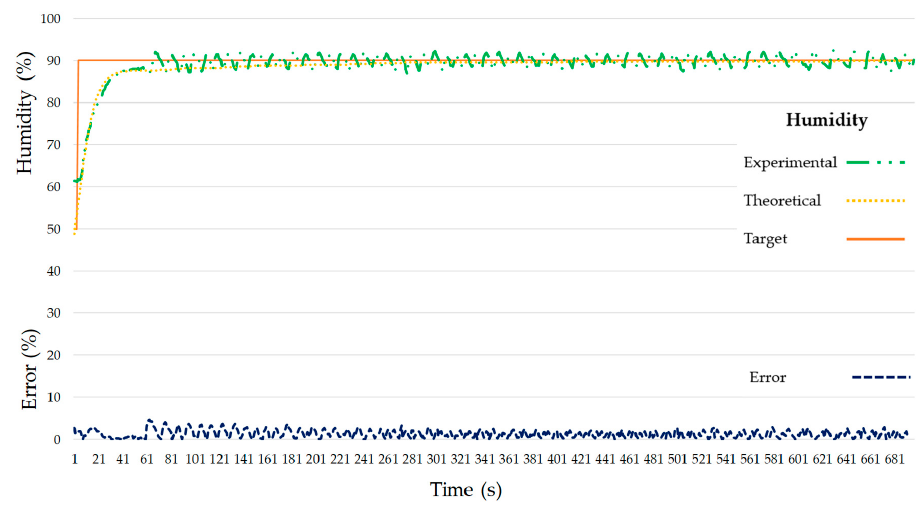
Figure 13. Target, model and experimental humidity with experimental humidity error.